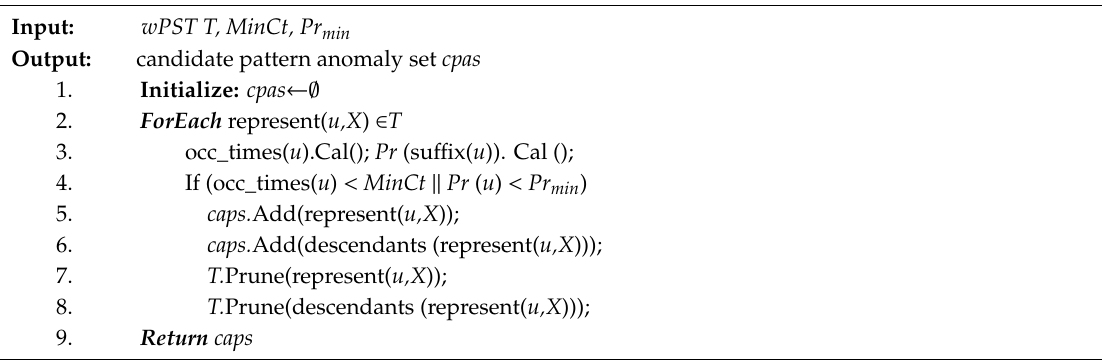
Algorithm 2 Candidate anomaly pattern mining. Mine_Candidate_Anomaly ( wPST T , int MinCt, real Pr min